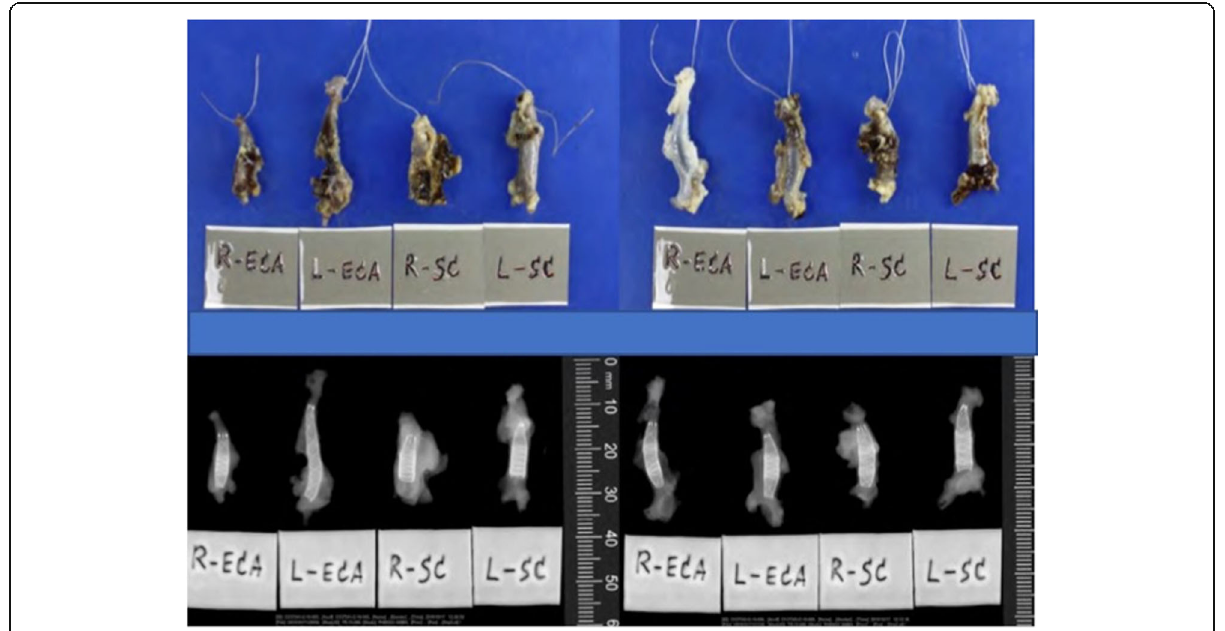
Fig. 7 Macroscopic and radiographic analysis of the explanted vessel segments of subjects number 3 and 4